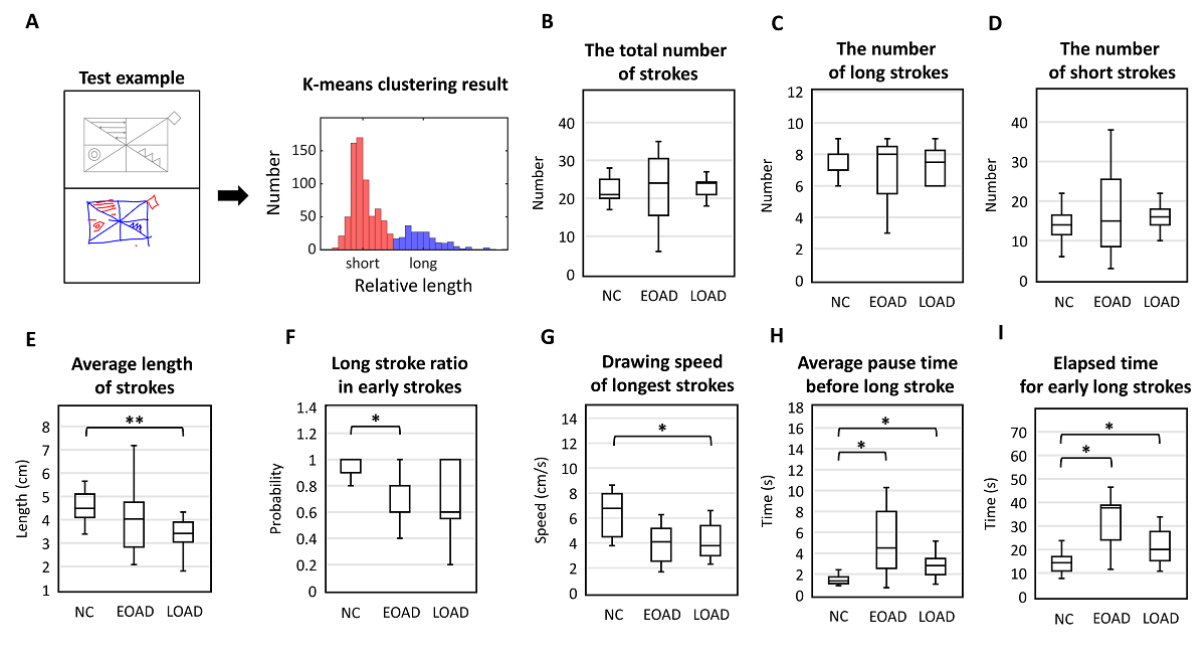
Figure 2. Pen stroke analysis. Clinical interpretation of copying performance in the Rey-Osterrieth Complex Figure Test (RCFT) was partly based on how an individual draws the image based on consecutive line creations. The number, length, and speed of strokes were analyzed. (A) Long (blue)/short (red) strokes are classified by k-means clustering; (B-D) number of strokes; (E-F) length of strokes; (G-I) speed of strokes. One and two asterisks show significant differences at P <.05 and P <.01 levels, respectively. EOAD: early-onset Alzheimer disease; LOAD: late-onset Alzheimer disease; NC: normal